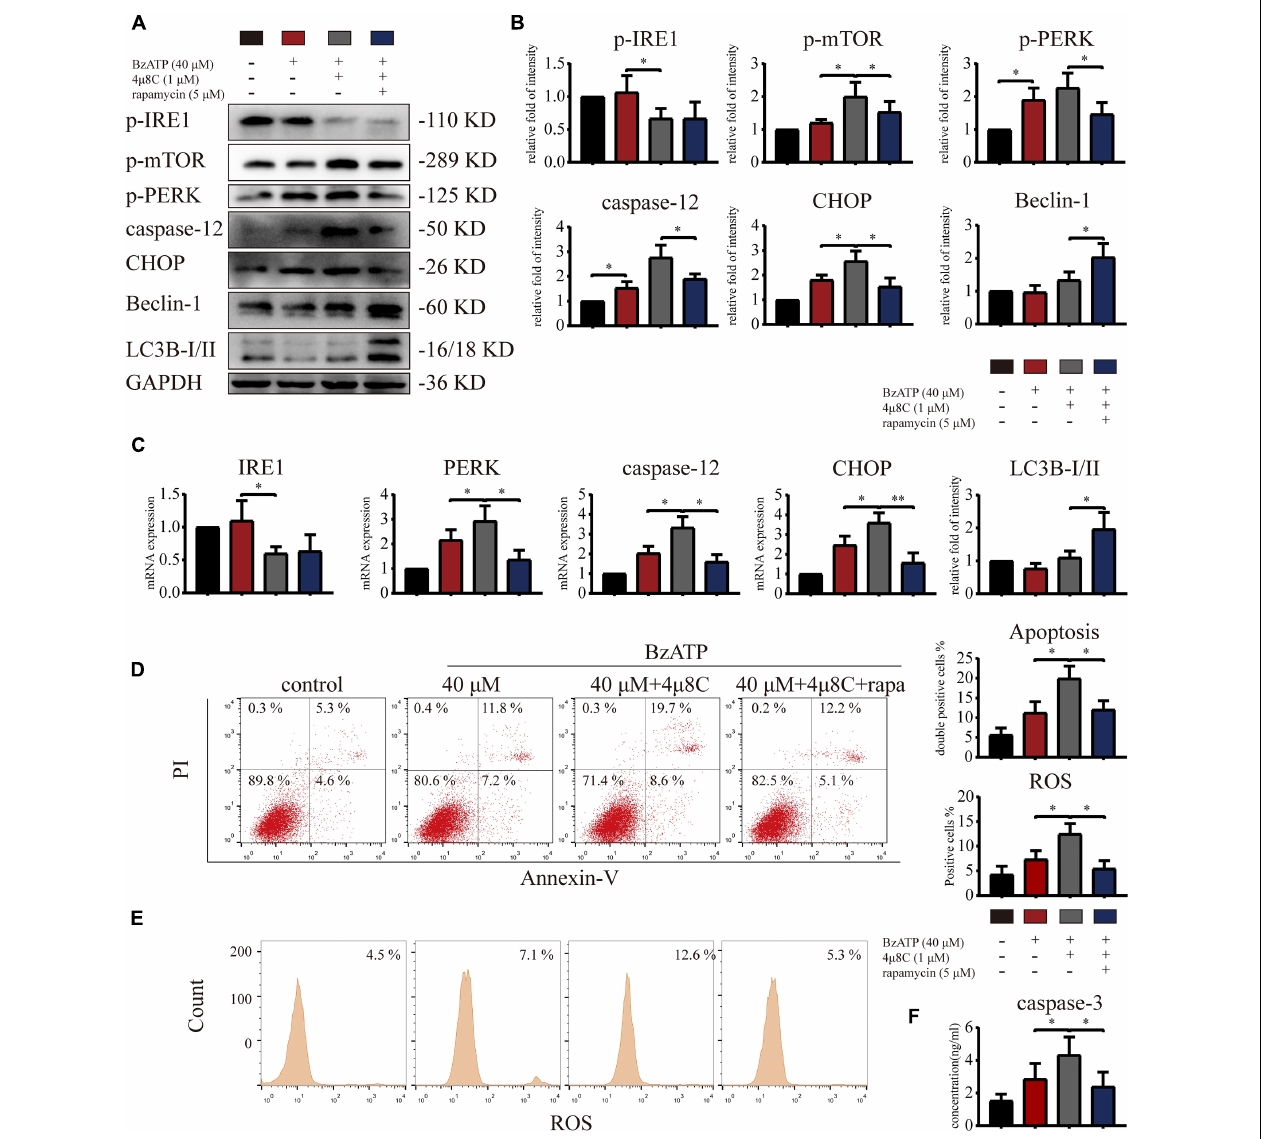
FIGURE 7 | Inositol-requiring enzyme-1 inhibits mTOR and reduces ER stress-apoptosis. Cells were cultured with 40 µ M Bz-ATP, 1 µ M 4 µ 8C, and 5 µ M rapamycin. Western blotting (A,B) and qRT-PCR (C) were used to detect the protein and mRNA expression levels of IRE1 , mTOR, PERK , caspase-12 , CHOP , LC3B, and Beclin-1. Flow cytometry was used to detect the percentage of double-stained Annexin-V/PI cells (D) and the level of intracellular oxidative stress, ROS (E) . (F) The caspase-3 activity assay; the statistical results are homogenized. Data are expressed as means ± standard deviations of at least three independent experiments. ∗ p < 0.05, ∗∗ p <